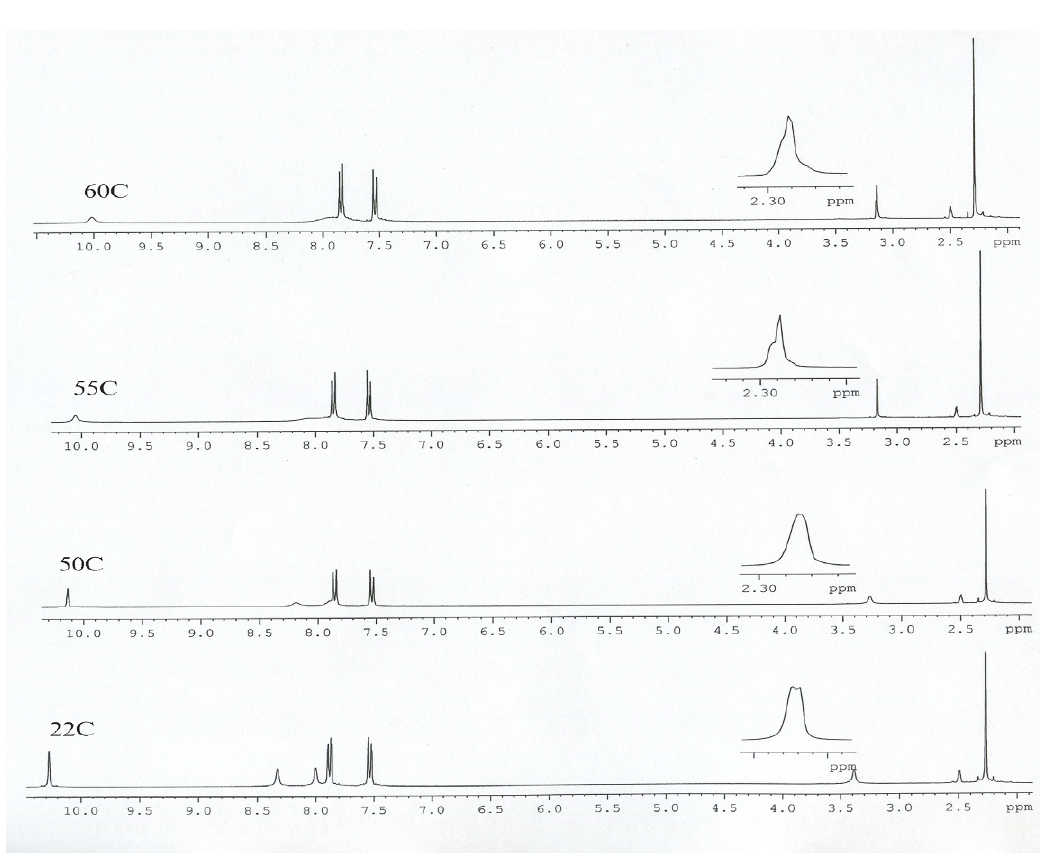
Figure 3. 1 H NMR spectrum of ( E )-4-bromoacetophenone thiosemicarbazone ( III ) in DMSO-d